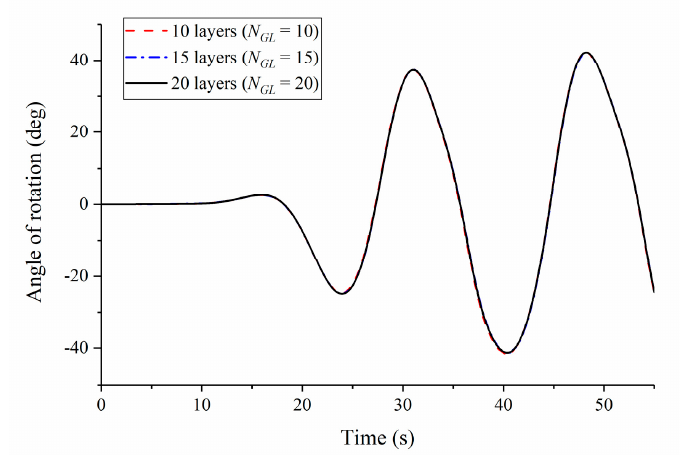
Figure 10. The comparison of time–history responses of a flap without a PTO system ( C PTO = 0 and T PTO = 0) under a regular wave ( A i = 1 m and T = 17.5 s) among different overset zone sizes ( N GL = 10, N GL = 15 and N GL = 20).